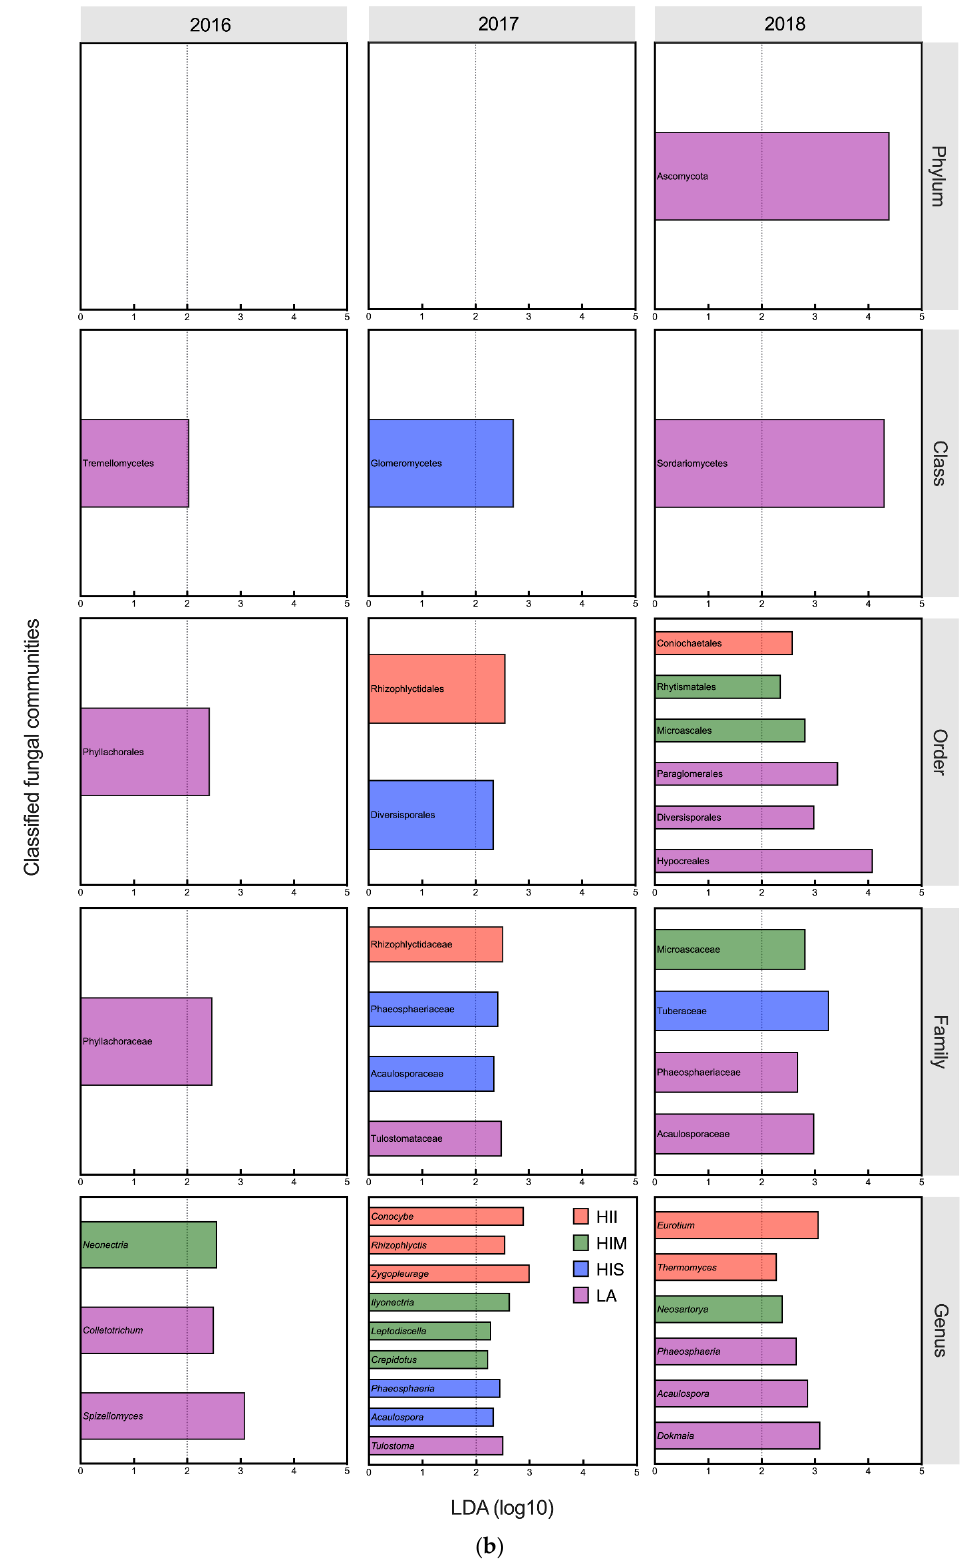
Figure 4. The Linear Discriminant Analysis (LDA) results of microbial communities at the genus level. Only the classified genera (selected genera) were exhibited in the figure. The cutoff of LDA score is 2. ( a ) The effects of management groups on bacterial genera; ( b ) The effects of management groups on fungal